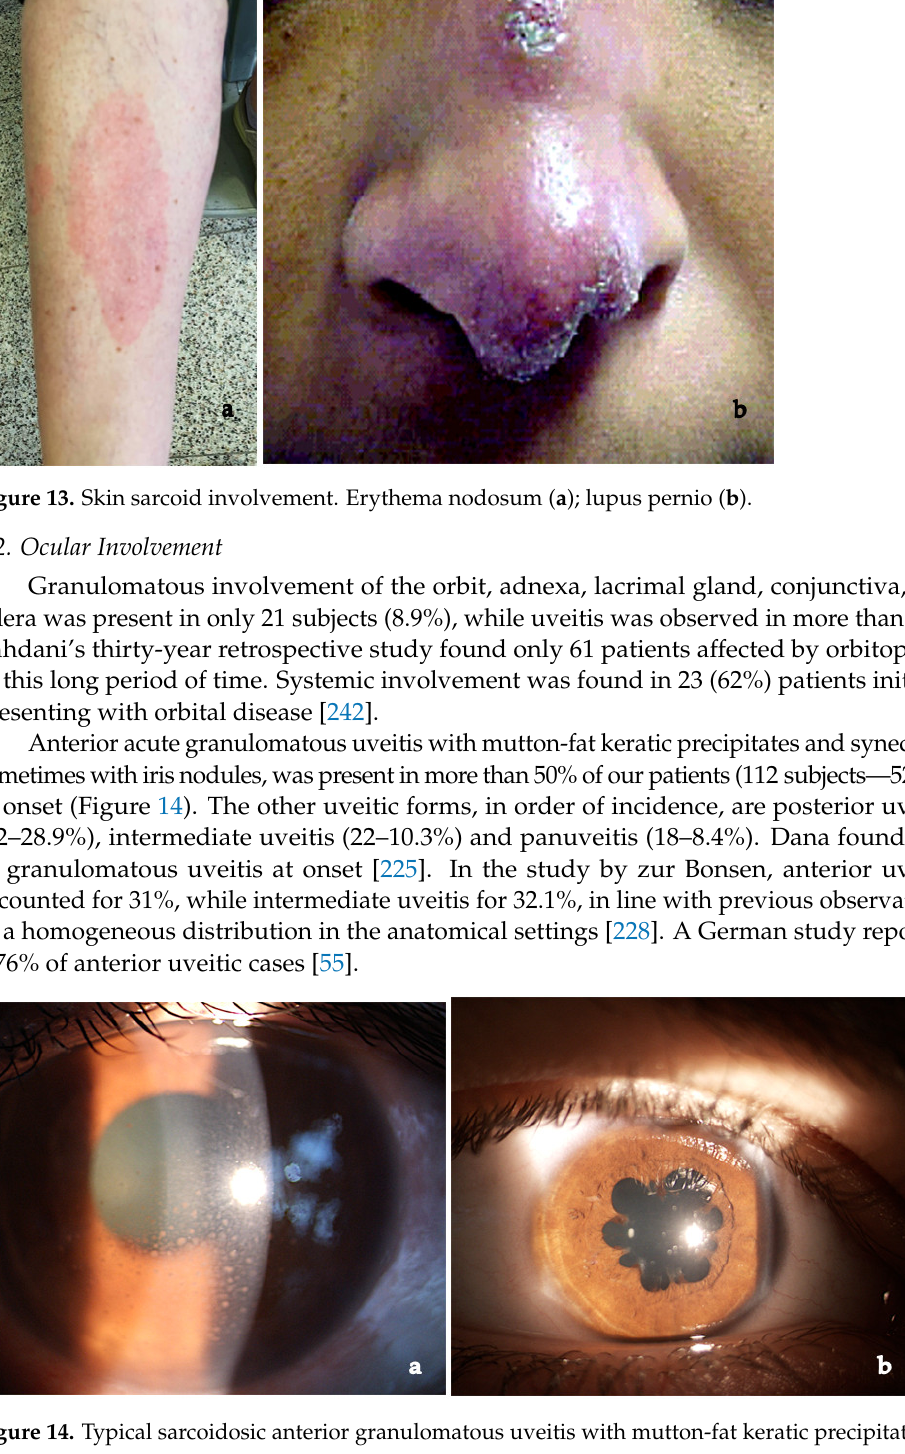
Figure 15. Different aspects of intermediate sarcoid uveitis. Snowballs ( a ); acute inflammatory vitreitis ( b ); chronic vitreitis ( c ). Posterior uveitis was the typical finding in our patients. It is characterized by non- occlusive retinal periphlebitis (especially venous), vascular sheathing, candle-wax drip- pings (perivenous exudates), multifocal choroiditis (mainly in the periphery), hemor- rhagic retinopathy, multiple serous RPE detachments, CME, papillitis, optic nerve granu- lomas, papilledema, and retinal arteriolitis with macro-aneurisms (mainly in older pa- tients) (Figure 16). It was present in a fairly high percentage of patients, reaching almost one-third of cases, more than previously described by other authors [59,228]. This high incidence may be related, in our opinion, to a diagnostic and/or therapeutic delay in our group of patients and to the chronic evolution of the disease, probably due to a genetic predisposition. A reason for these dissimilarities may be found in the heterogeneity of the populations included in previous studies (i.e., different ethnicity). Moreover, patients af- fected by severe disease are usually treated at referral centers and, therefore, present dif- ferent incidence and characteristics as compared to general hospitals.